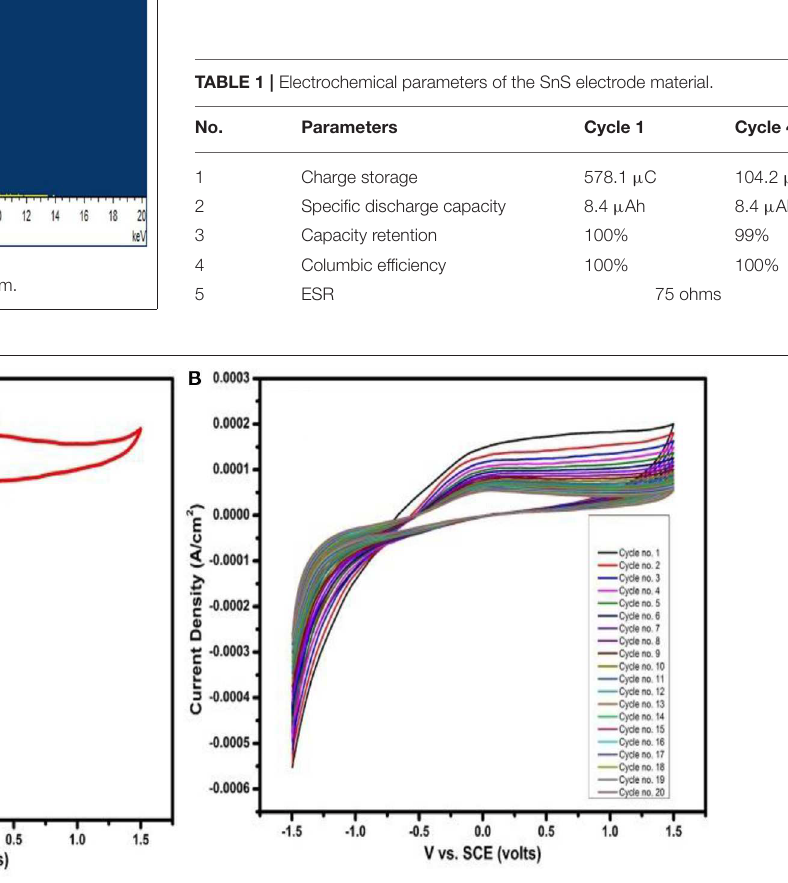
FIGURE 5 | (A) Cyclic voltammetry glass/FTO/SnS electrode at scan rate of 100 mV/s and (B) shows 20 cycles at scan rate of 100 mV/s.